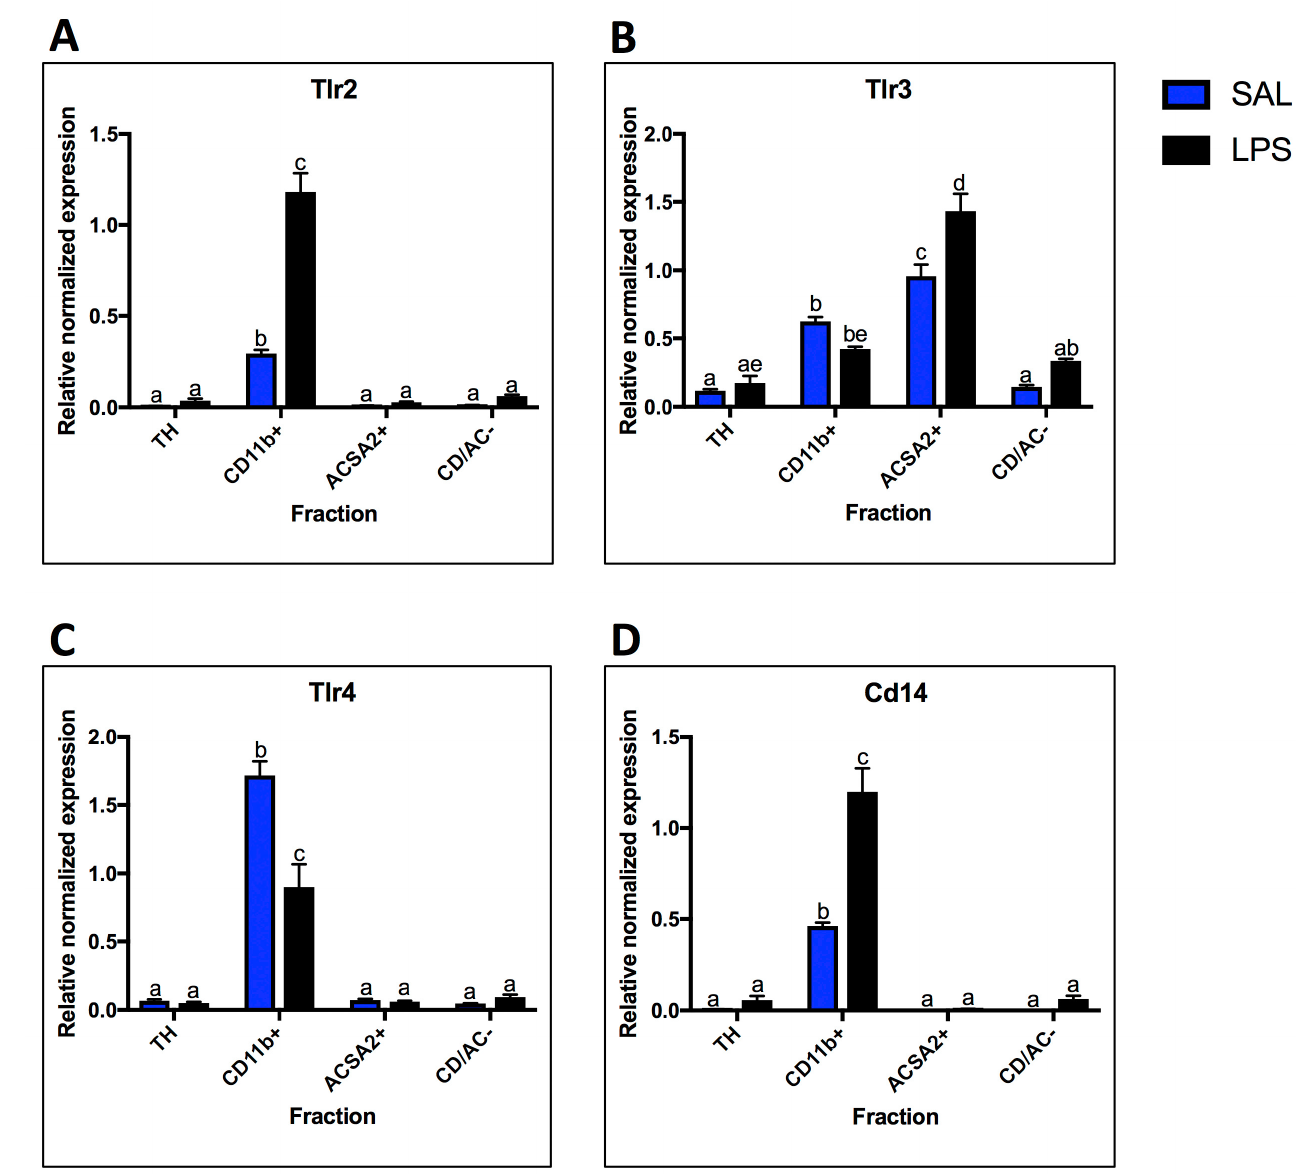
Figure 3. Toll-like receptor (TLR) mRNA expression. Fraction localization and LPS expression changes for TLRs and co-receptors measured by qPCR. A. Tlr2 is expressed primarily in the microglial fraction and expression increases with LPS. B. Tlr3 is enriched in both microglia and astrocytes compared to the total homogenate (TH), with higher expression in astrocytes. Astrocyte Tlr3 expression increased with LPS. C. Tlr4 expression is highly microglial and decreases following LPS. D. Cd14 is highly enriched in microglia and increases with LPS. Two bars with the same letter are not statistically different; two bars with no letter in common are statistically different (two-way ANOVA with Tukey’s test for multiple comparisons, p<0.05). SAL, saline; LPS,